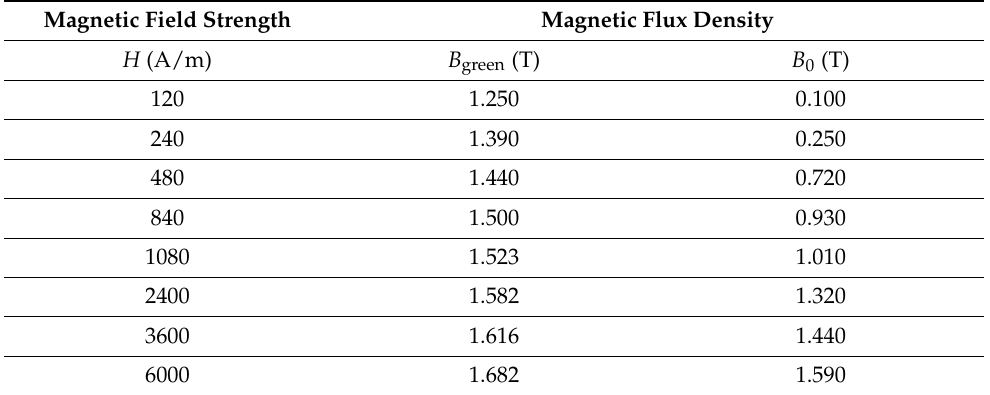
Table 1. Model data obtained as a result of direct measurements of the strips cut at an angle of 0